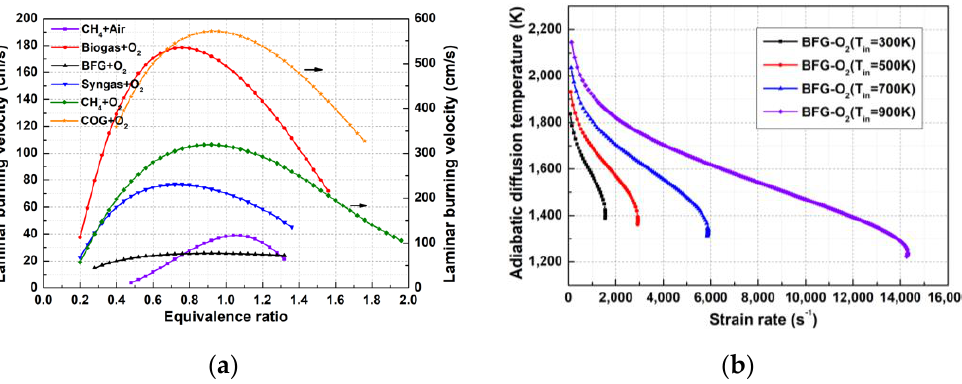
Figure 2. Effects of oxy-fuel combustion on combustion characteristics. ( a ) laminar flame speed;( b ) adiabatic temperature.